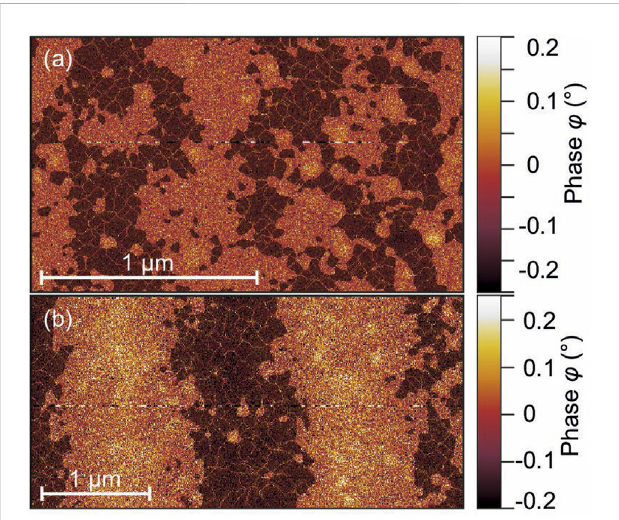
FIGURE 2 Magnetic force microscopy measurements at two different positions (A) and (B) of afully irradiated and otherwise untreated anatase thin fi lm. The TiO 2 thin fi lm was irradiated with Ar + ions with a fl uence of ~ 10 16 cm − 2 and energy of 200 eV. The magnetic domains have been segmented with a barrier of 40% and a Gaussian smoothing factor of 8